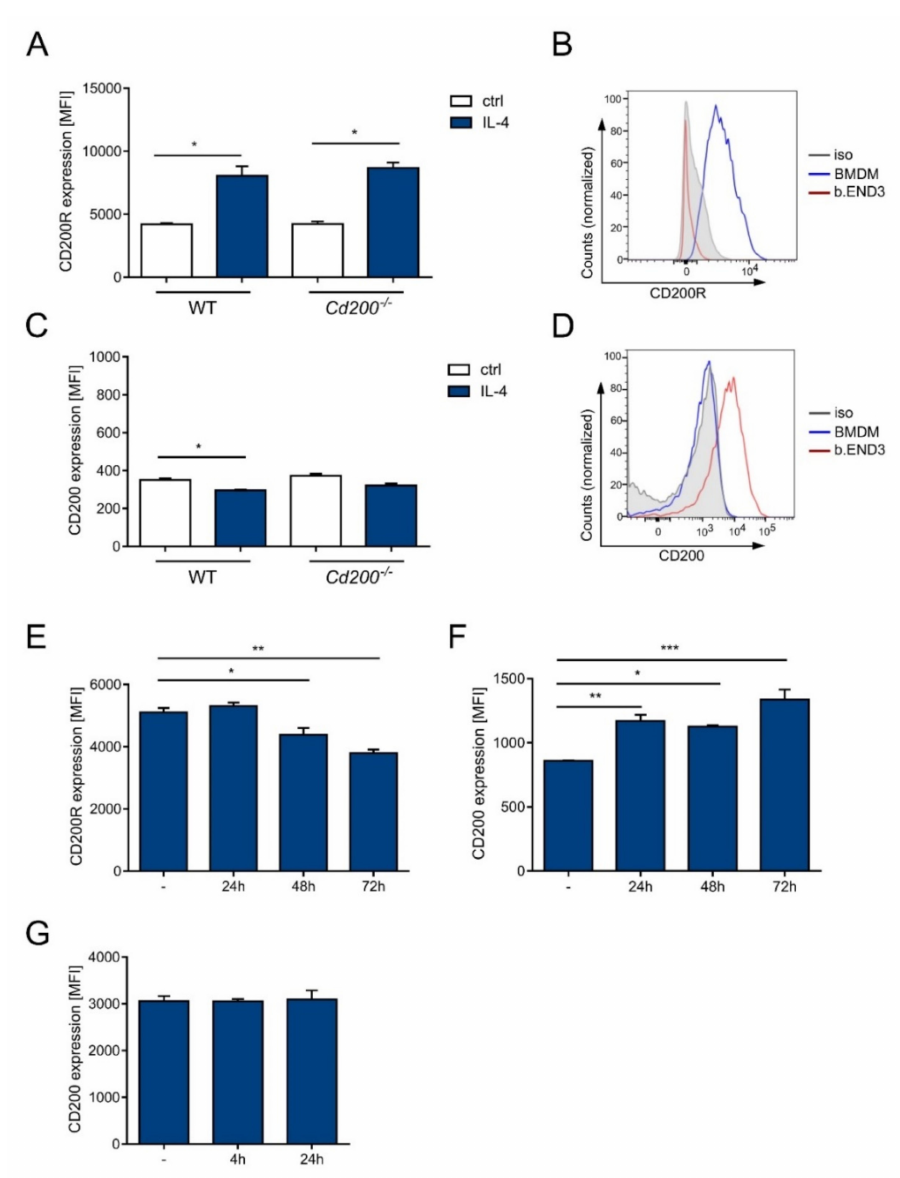
Figure 5. Expression of CD200R and CD200 in BMDMs under IL-4 or LPS stimulation. ( A ) Expression of CD200R in BMDMs isolated from WT and Cd200 − / − mice with or without IL-4 stimulation (20 ng/mL for 24 h), n = 2; ( B ) Exemplary histogram showing expression of CD200R in b.END3